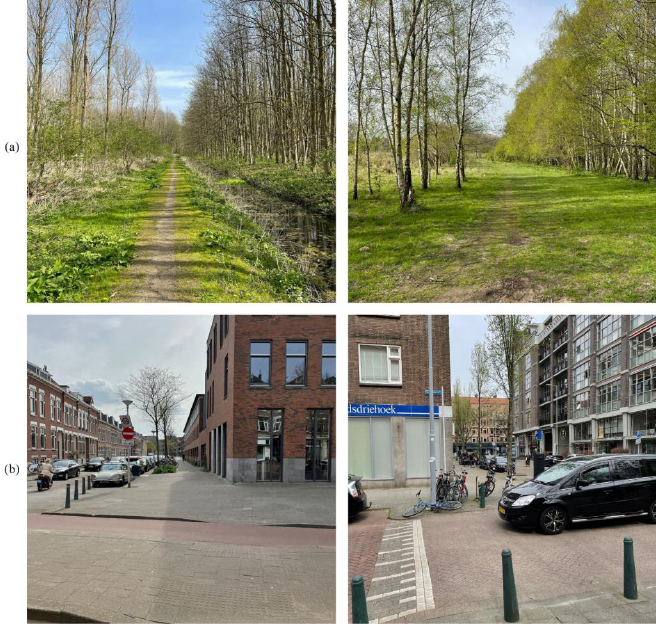
Figure 1. The first row of pictures ( a ) indicates a sample of two pictures used in the nature condition, the second row of pictures ( b ) indicates a sample of two pictures used in the urban condition.